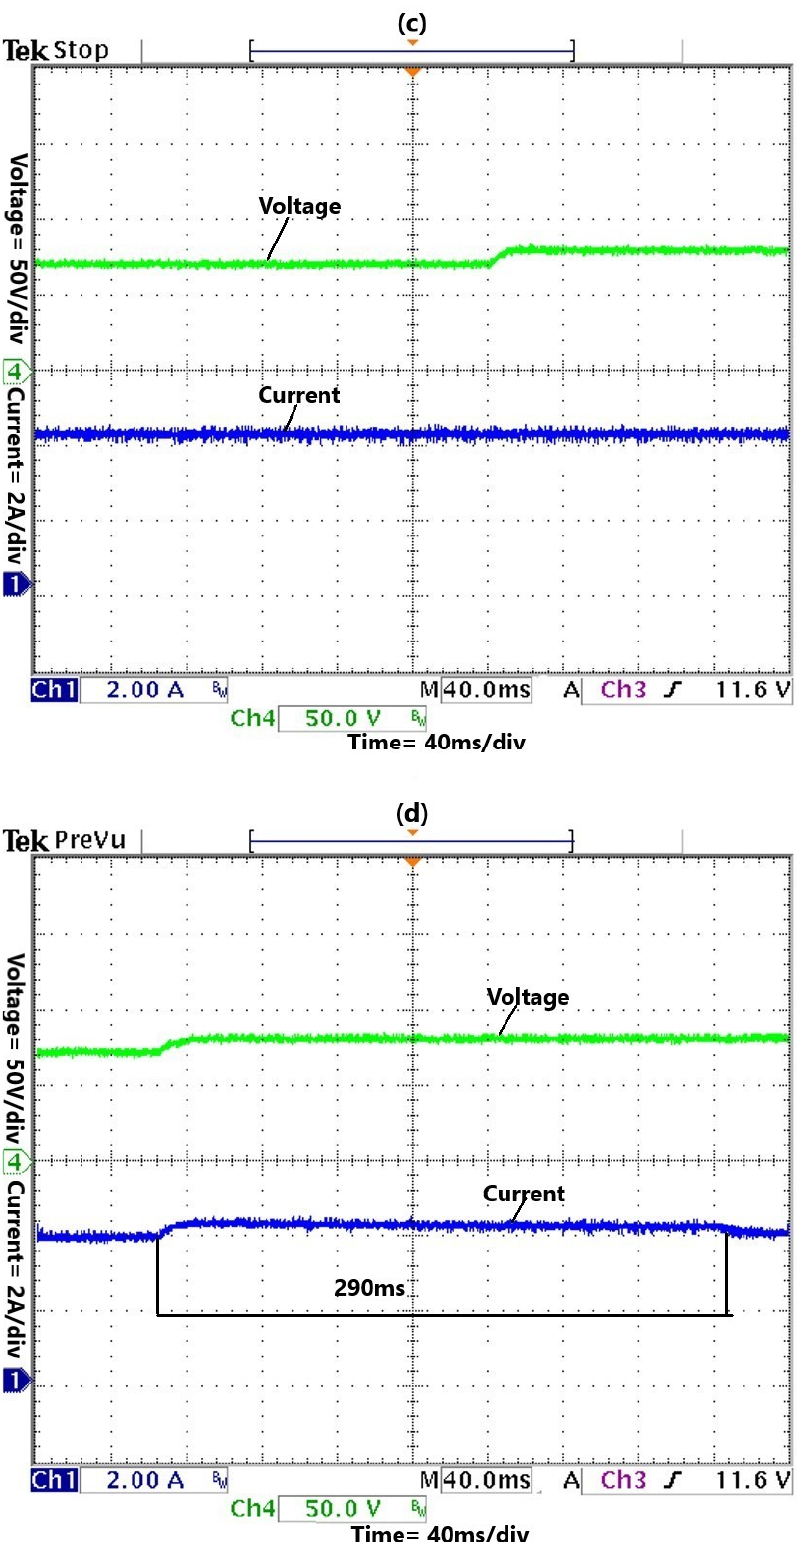
Figure 18. Experimental results during input voltage step-up (65 V to 75 V): ( a ) FCC; ( b ) LCFF; ( c ) MBPS; ( d ) PI.